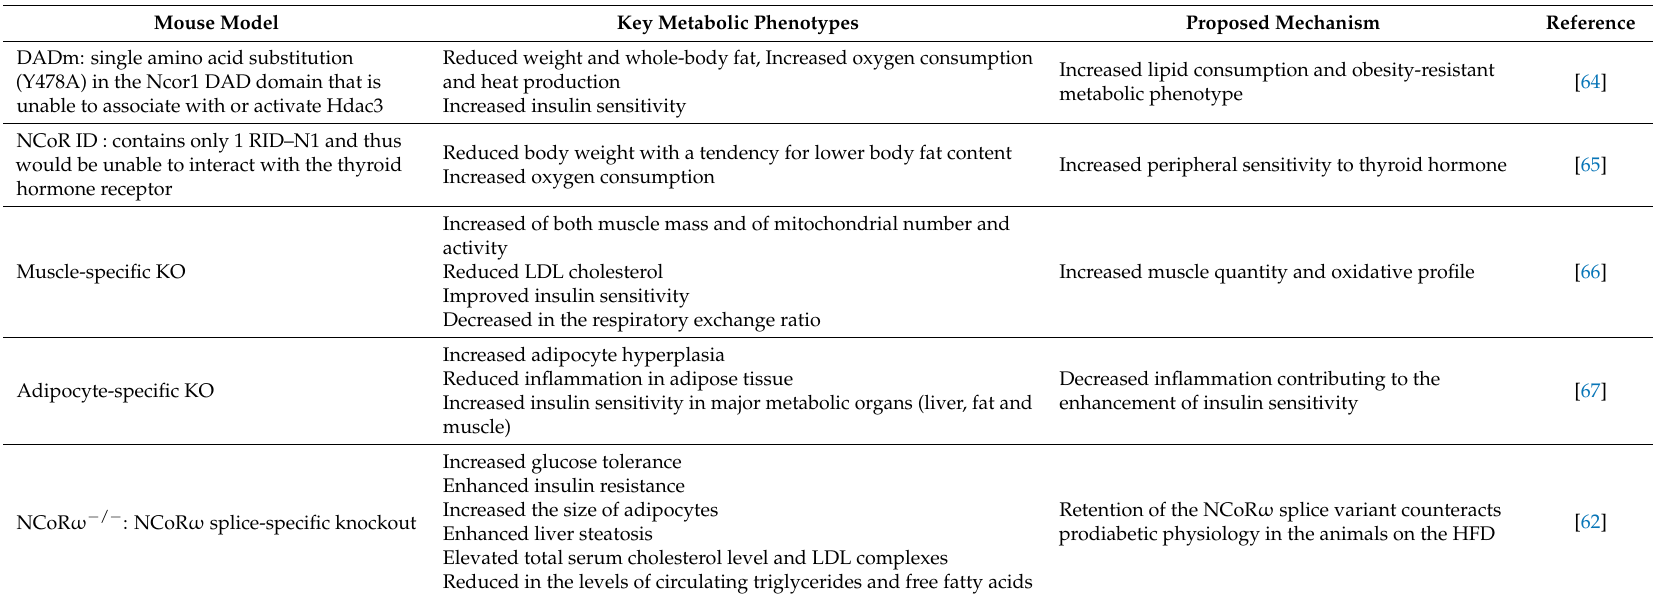
Table 1. Summary of the different Nuclear Receptor Corepressor 1 (NCoR1) mouse